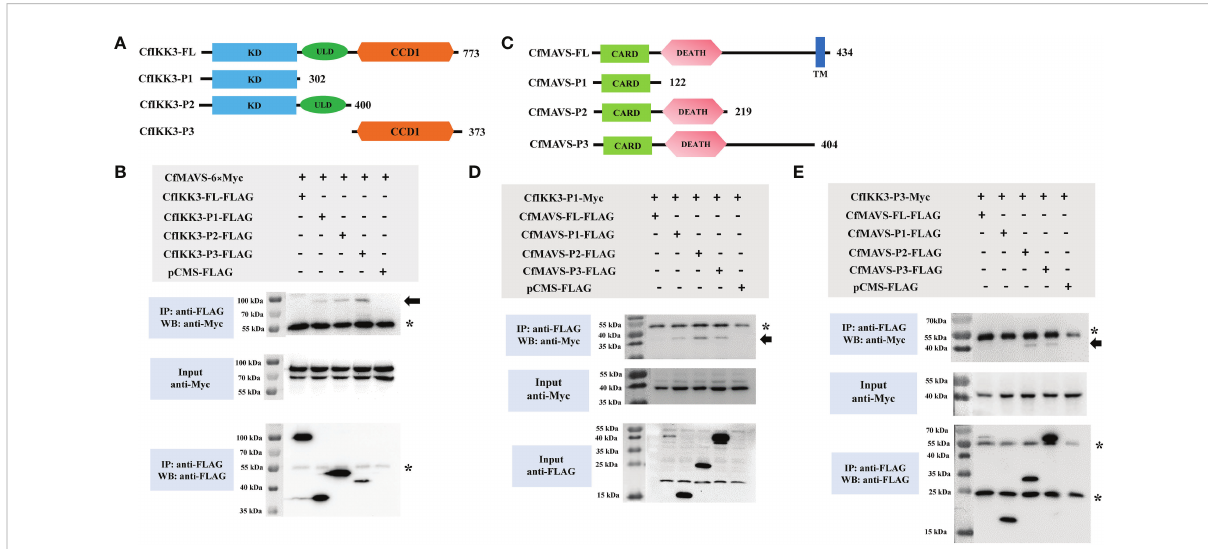
FIGURE 6 (A) Schematic representations of the wild-type full-length CfIKK3 protein (CfIKK3-FL) and truncated mutant CfIKK3-P1, CfIKK3-P2, and CfIKK3- P3 proteins. The protein lengths and domains are annotated. (B) Interaction between CfIKK3 and CfMAVS, as veri fi ed using co- immunoprecipitation (co-IP) assays. Co-IP results indicated the interaction of CfMAVS-6×Myc with CfIKK3-P1-FLAG, CfIKK3-P2-FLAG, and CfIKK3-P3-FLAG. Asterisk represents the heavy chain of mouse IgG. (C) Schematic representations of the wild-type full-length CfMAVS protein (CfMAVS-FL) and truncated mutant CfMAVS-P1, CfMAVS-P2, and CfMAVS-P3 proteins. The protein lengths and domains are annotated. (D) Interaction between CfIKK3-P1 and CfMAVS, as veri fi ed using co-immunoprecipitation (co-IP) assays. Co-IP results indicated the interaction of CfIKK3-P1-Myc with CfMAVS-P1-FLAG, CfMAVS-P2-FLAG, and CfMAVS-P3-FLAG. Asterisk represents the heavy chain of mouse IgG. (E) Interaction between CfIKK3-P3 and CfMAVS, as veri fi ed using co-immunoprecipitation (co-IP) assays. Co-IP results indicated the interaction of CfIKK3-P3-Myc with CfMAVS-P2-FLAG and CfMAVS-P3-FLAG. Asterisk represents the heavy chain or the light chain of mouse IgG.